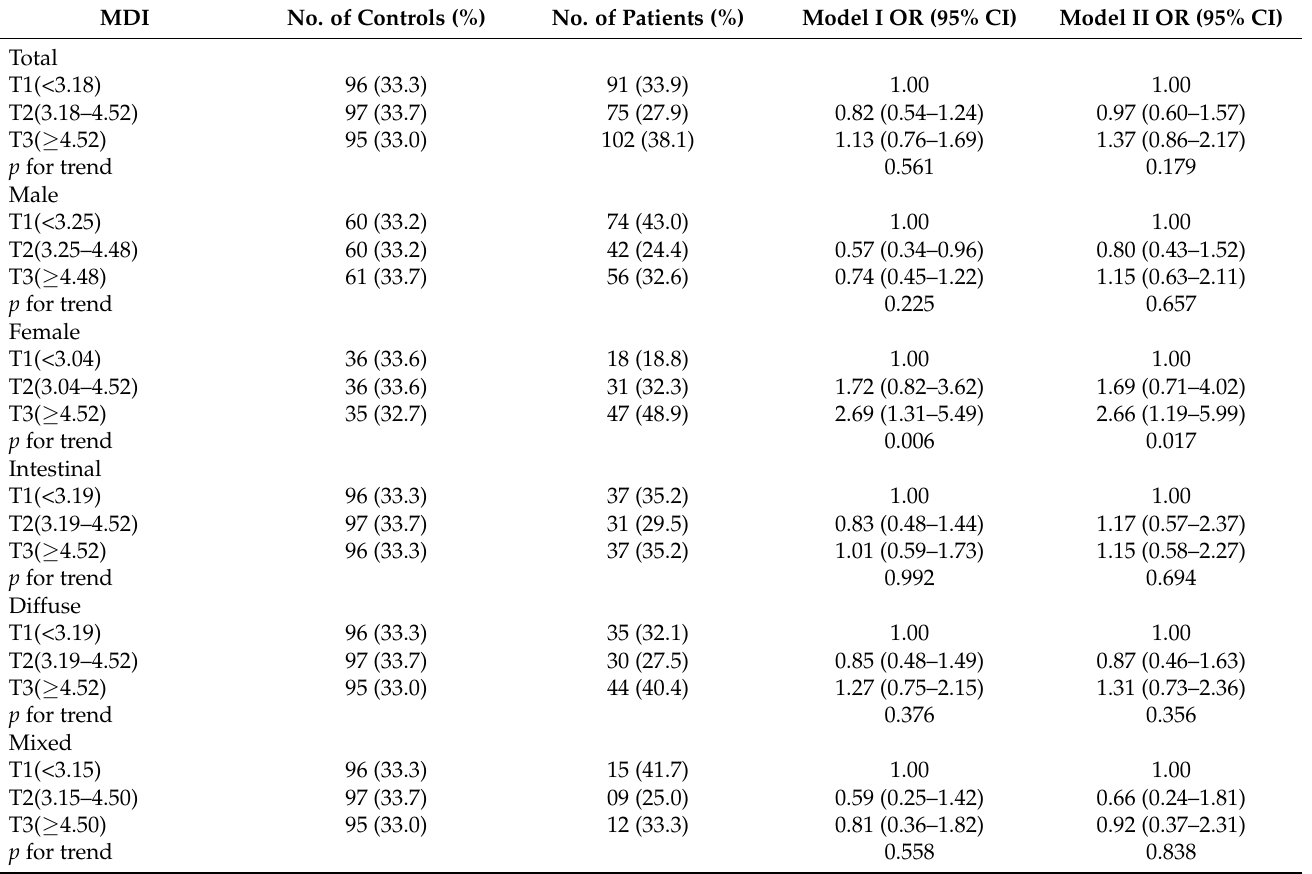
Table 4. Association between MDI and the GC